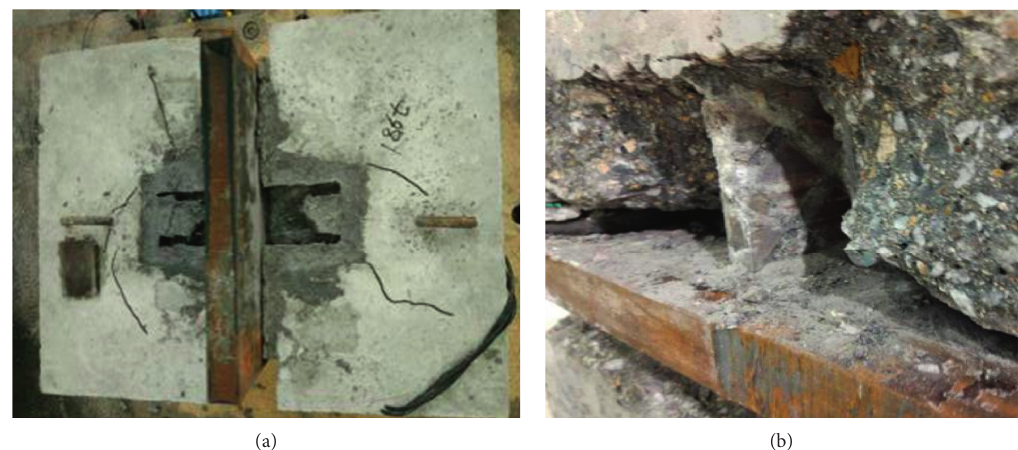
Figure 12: Typical failure mode of push-out test specimens: (a) top face; (b) bottom face.